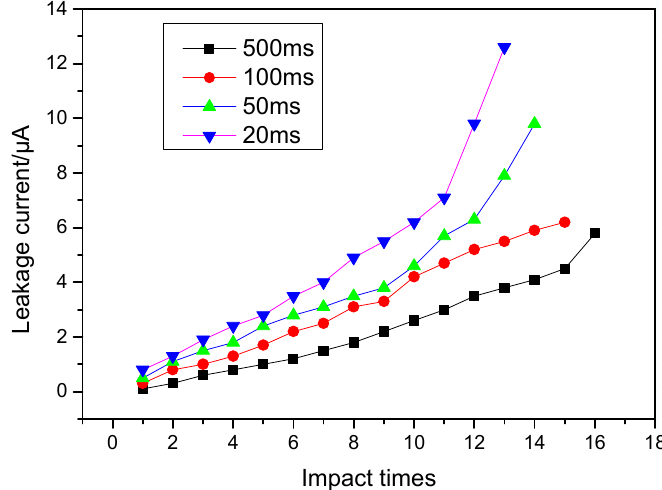
Figure 6. The relationship between the leakage current of ZnO varistors and the number of impacts at different pulse intervals.